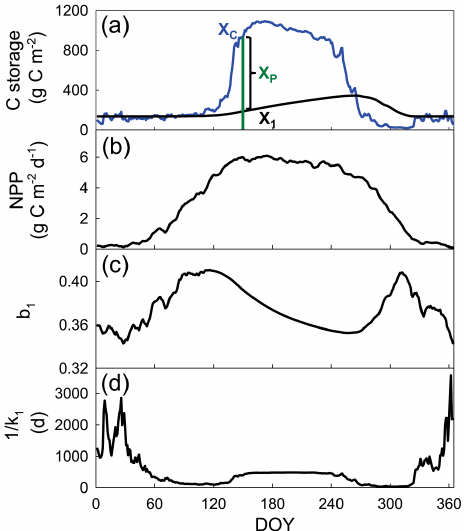
Figure 2. Seasonal cycles of C storage capacity and C storage dy- namics for the leaf pool (i.e., pool 1 as shown in Fig. 1). All the com- ponents are shown in panels (b–d) to calculate x c , 1 (t) = b 1 u(t)τ 1 through multiplication, where u(t) = NPP and τ 1 = 1 /k 1 for